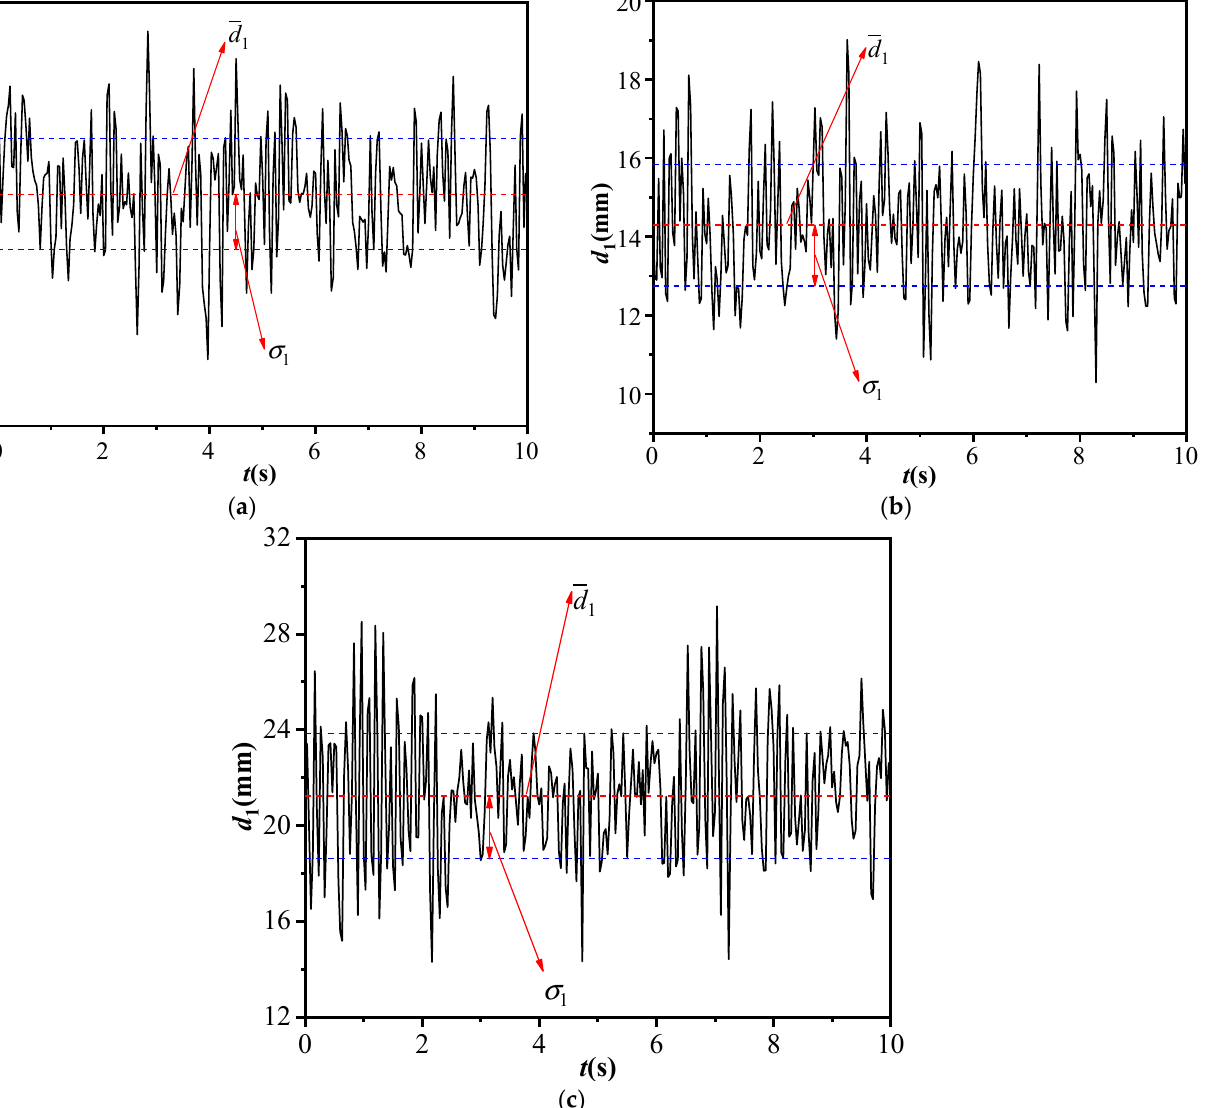
Figure 9. Time–history curve of displacement of the top region (d 1 ) at each wind speed: ( a ) u = 7.5 m/s, ( b ) u = 9 m/s, and ( c ) u = 11 m/s. To better visualize the trend of the average deformation and amplitude of the mem- brane surface with wind speed, the time-averaged deformation and the standard deviation of the displacement of each characteristic measurement point (d 1 , d 2 , and d 3 ) are used to characterize the overall membrane surface.